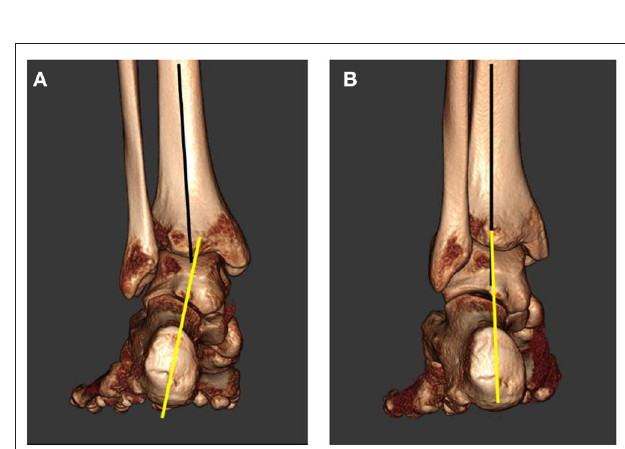
excessive forces remain unchecked, chronic inflammation will result leading to arthritis and joint